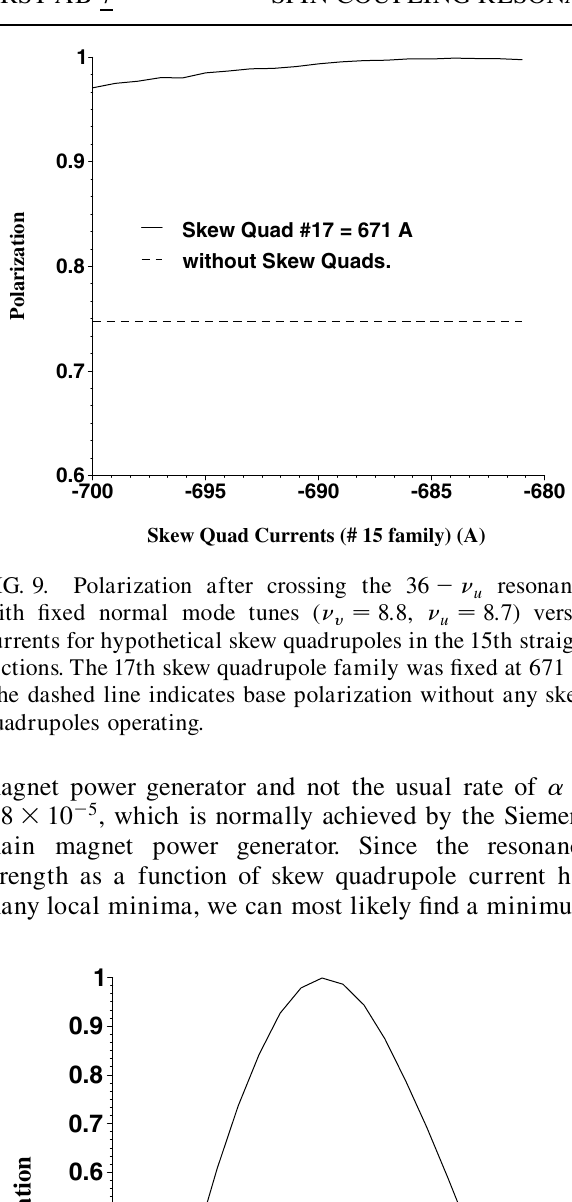
resonance u (cid:3) 8 : 8 , (cid:28) (cid:3) 8 : 7 ) versus v u